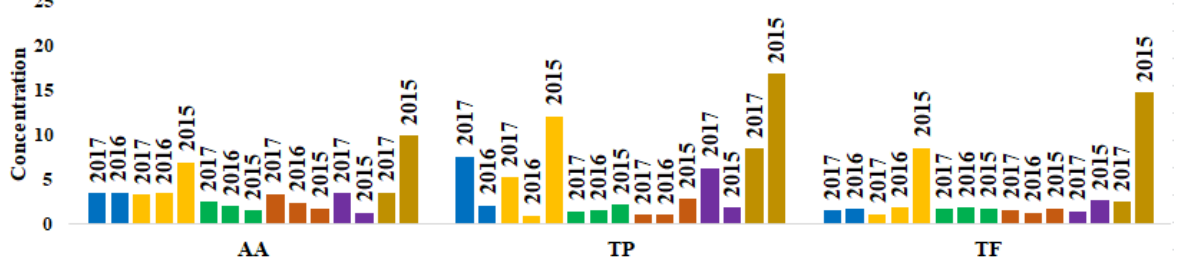
Figure 1. Antioxidant activity (AA) expressed as μ moli Trolox equivalents/g, Total polyphenols (TP) expressed as mg GAE equivalents/g and Total Flavonoids (TF) expressed as mg rutin equivalents/g of the six chestnut cultivars for three consecutive years.